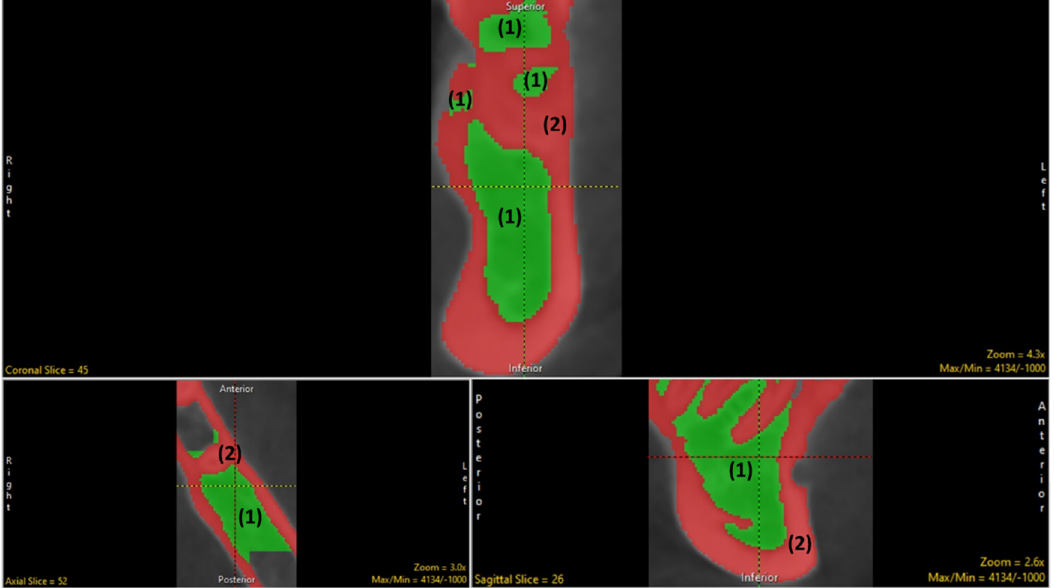
Figure 3. Bone segmentation into the (1) trabecular bone; (2) cortical bone.